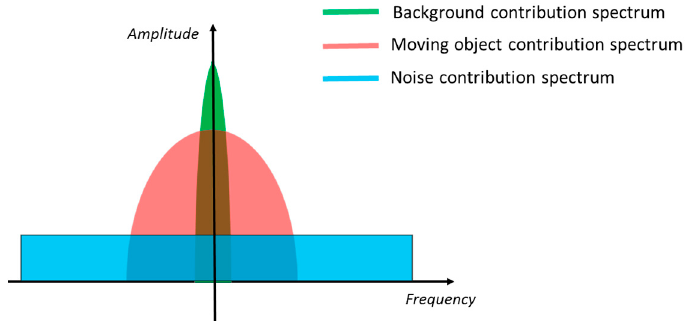
Figure 1. Schematic representation of the spectra of background (green), moving object (red) and noise (blue) contribution to the total intensity of a pixel of the video sequence.